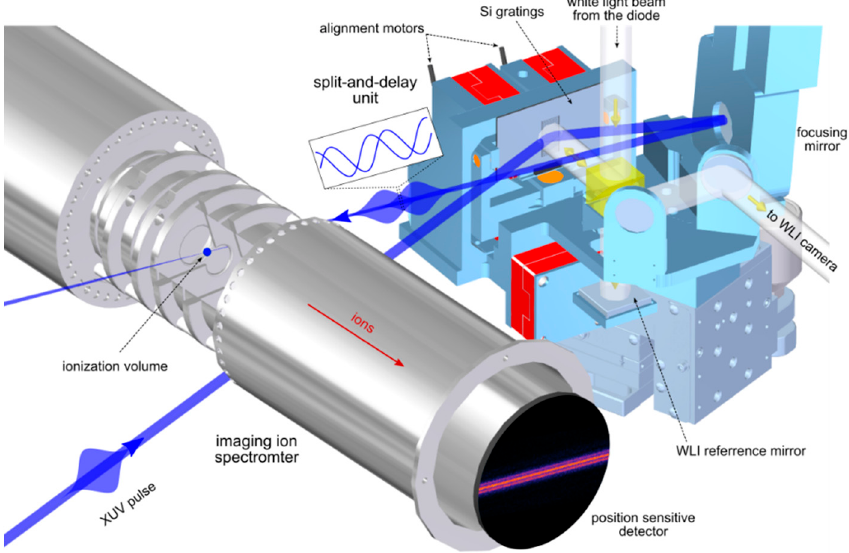
Figure 2. Layout of the experimental setup inside the vacuum chamber. As an illustration, the image on the position-sensitive detector (PSD) displays the spatial distribution of Xe + ions produced by 38 nm photons [22]. The image shows a characteristic triple foci structure generated by the SDU. The image is an accumulation of ~5000 shots including many different pulse-replica delays.